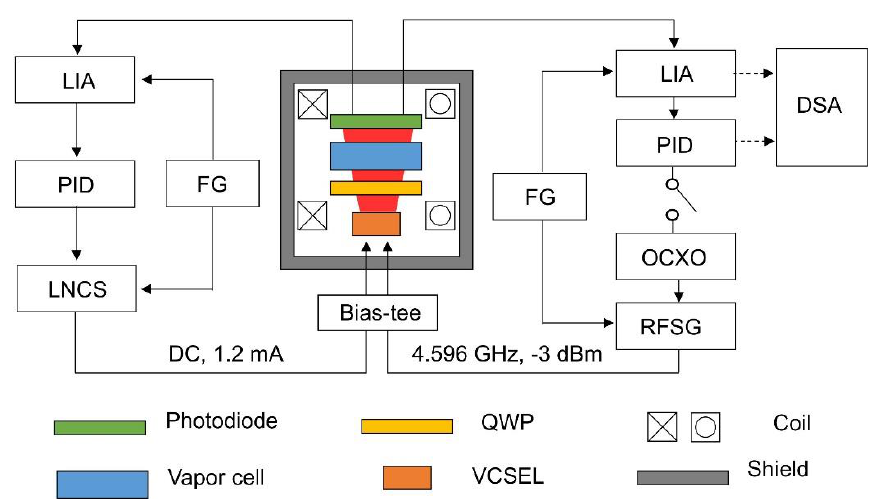
Figure 2. Schematic of the magnetometer package and measurement setup. Inside the shield is the spectroscopy unit and the instruments to control it are depicted outside the shield.